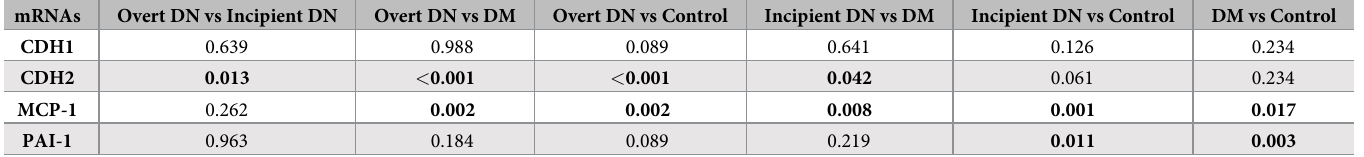
Table 4. Pairwise comparisons of overt DN group, incipient DN group, DM group, and control group versus each other. mRNAs Overt DN vs Incipient DN